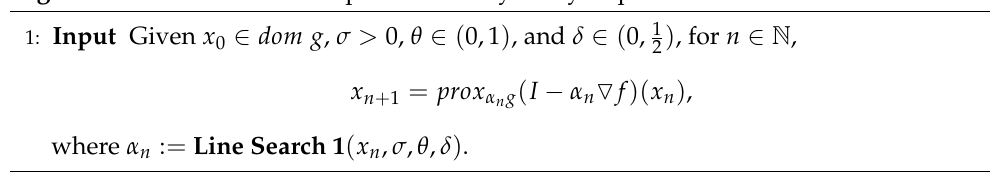
Algorithm 3. Line Search 1 stops after finitely many steps.